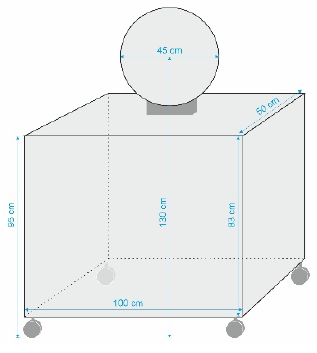
Figure 2. Sketch of the target.